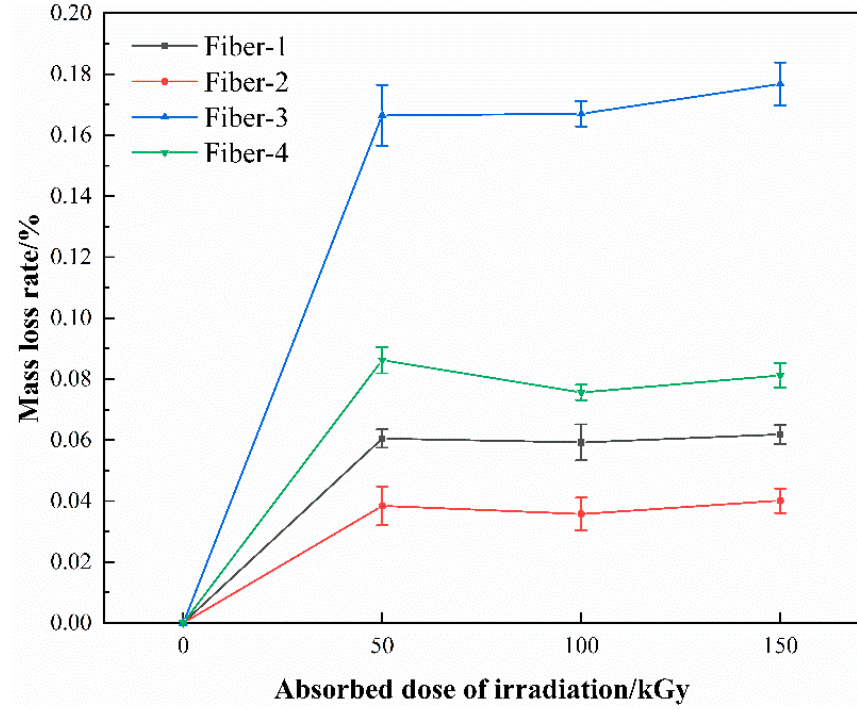
Figure 10. Variation of mass loss rate with the gamma irradiation absorbed dose.